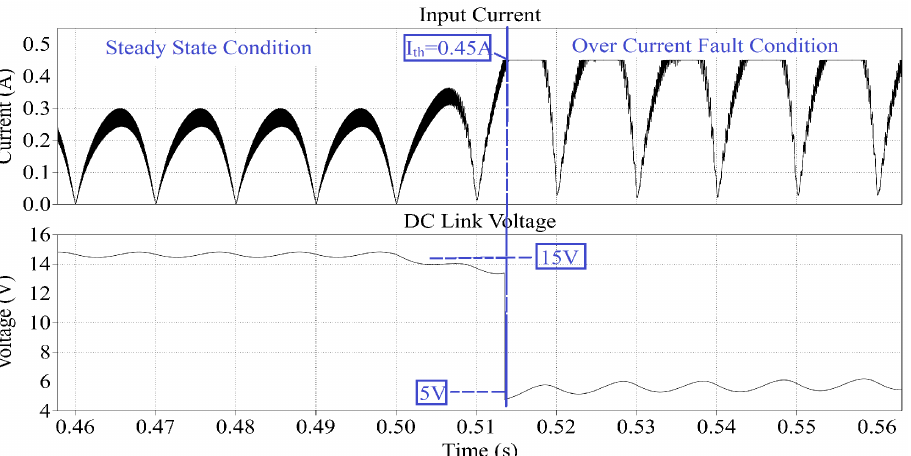
Figure 17. Transient simulation of over-current fault protection in the power supply, showing the input current i dc and DC link voltage v o